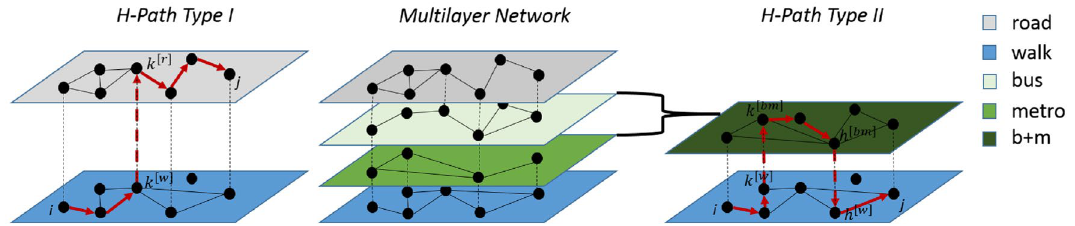
Figure 1. H-paths of type I and II in multimodal transportation networks. A transportation system is represented in the central panel as a multilayer network, where each layer accounts for a different mode of transportation, e.g, private cars (road), walking, bus system, metro. The left panel shows in red an example of a shortest H-path of type I with source and destination at two different layers and only one change at station k . The right panel is an example of a shortest H-path of type II . In this case the user moves to layer [ bm ] and travels in this layer from node k [ bm ] to node h [ bm ] , and then continues her trip in the original layer until the final destination j [ w ] is reached. As shown in this example, a layer can also be constructed by the aggregation of 2 or more layers (for example bus+metro [ bm ]